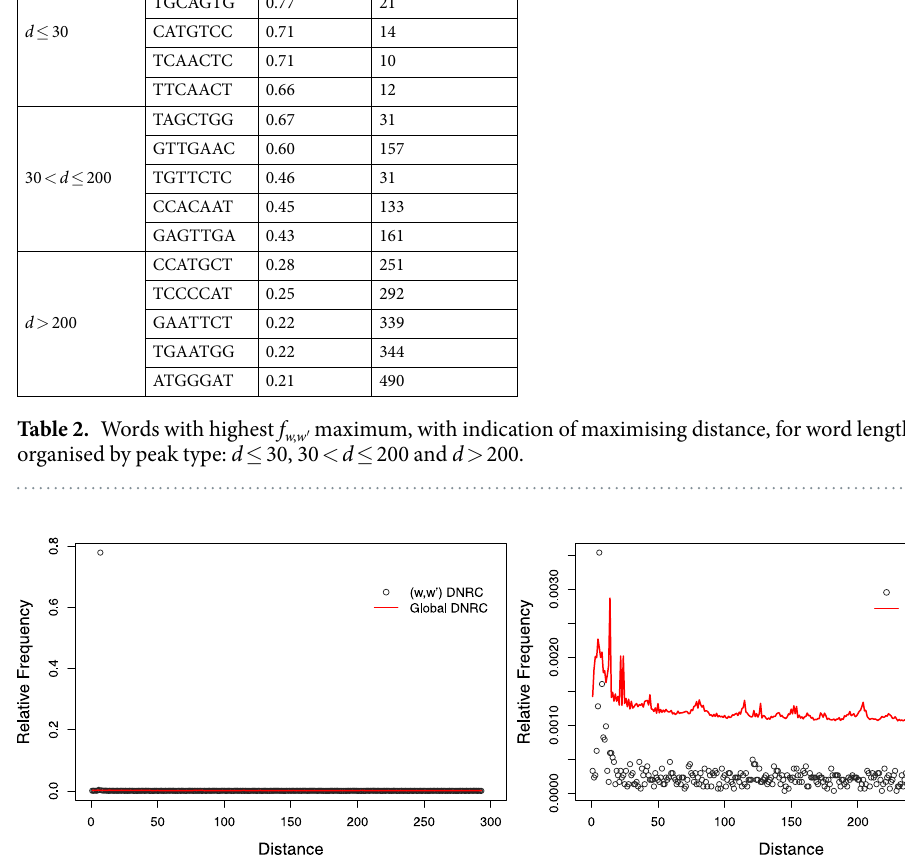
Figure 5. DNRC distribution f w , w ′ for w = CATTAGG , and global DNRC distribution, f k = 7 , for the complete human genome. Very strong enrichment for distance 14: f w , w ′ (14) = 0.778 (left). The right plot is a zoom of y